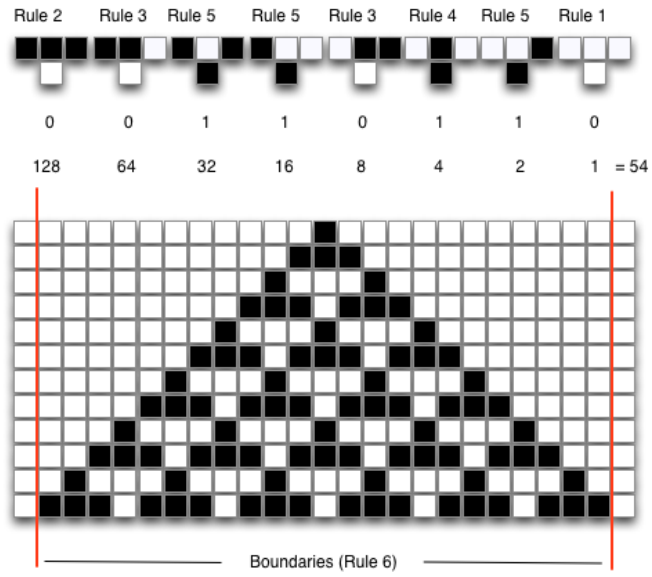
Fig. 1. Rule 54 Cellular Automaton. Each row represents one iteration at a